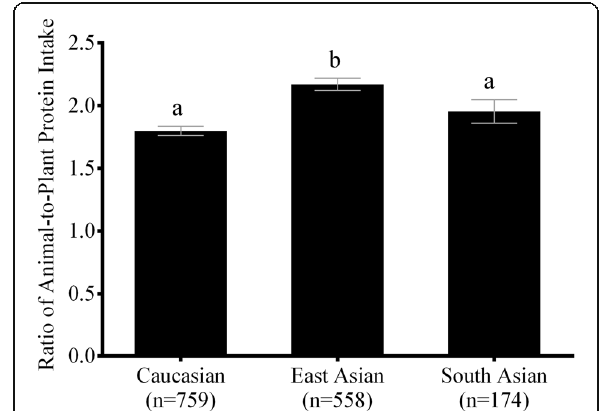
Fig. 1 Ratio of animal-to-plant protein intake across ethnocultural groups. Differences in the ratio of animal-to-plant protein intake between groups were compared using GLMs adjusted for age and sex. Groups without a common superscript letter differ after a Tukey-Kramer post hoc test ( p